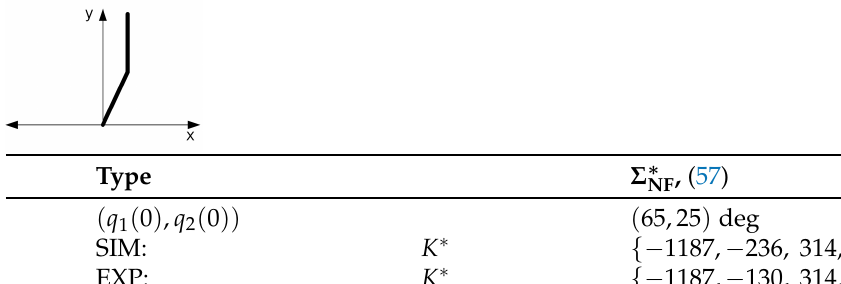
Table 10. Case C1: Initial posture of the Pendubot and parameters of the nonlinear controller.